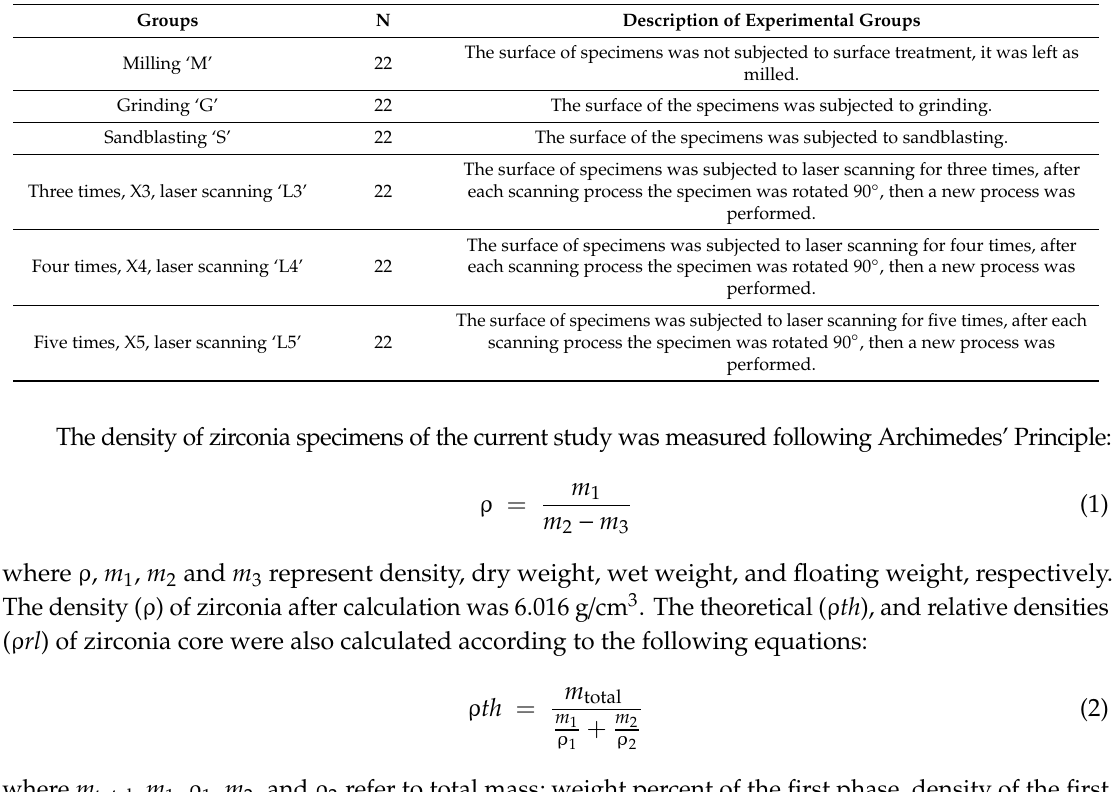
Table 3. Classification and description of experimental